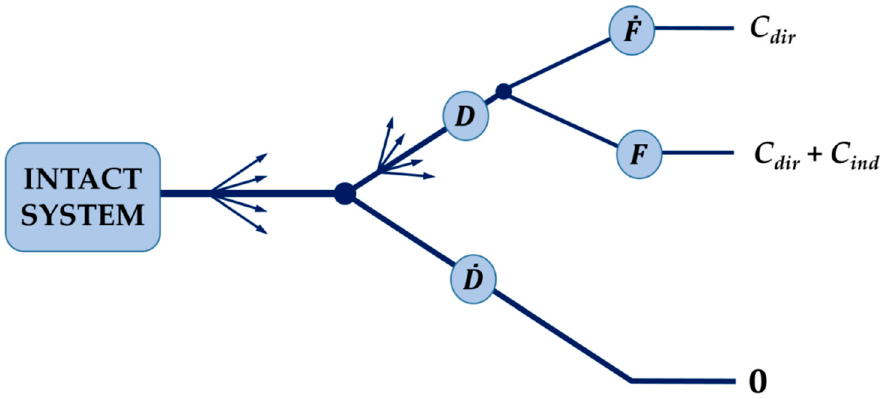
Figure 2. Direct and indirect consequences, adapted from [26].